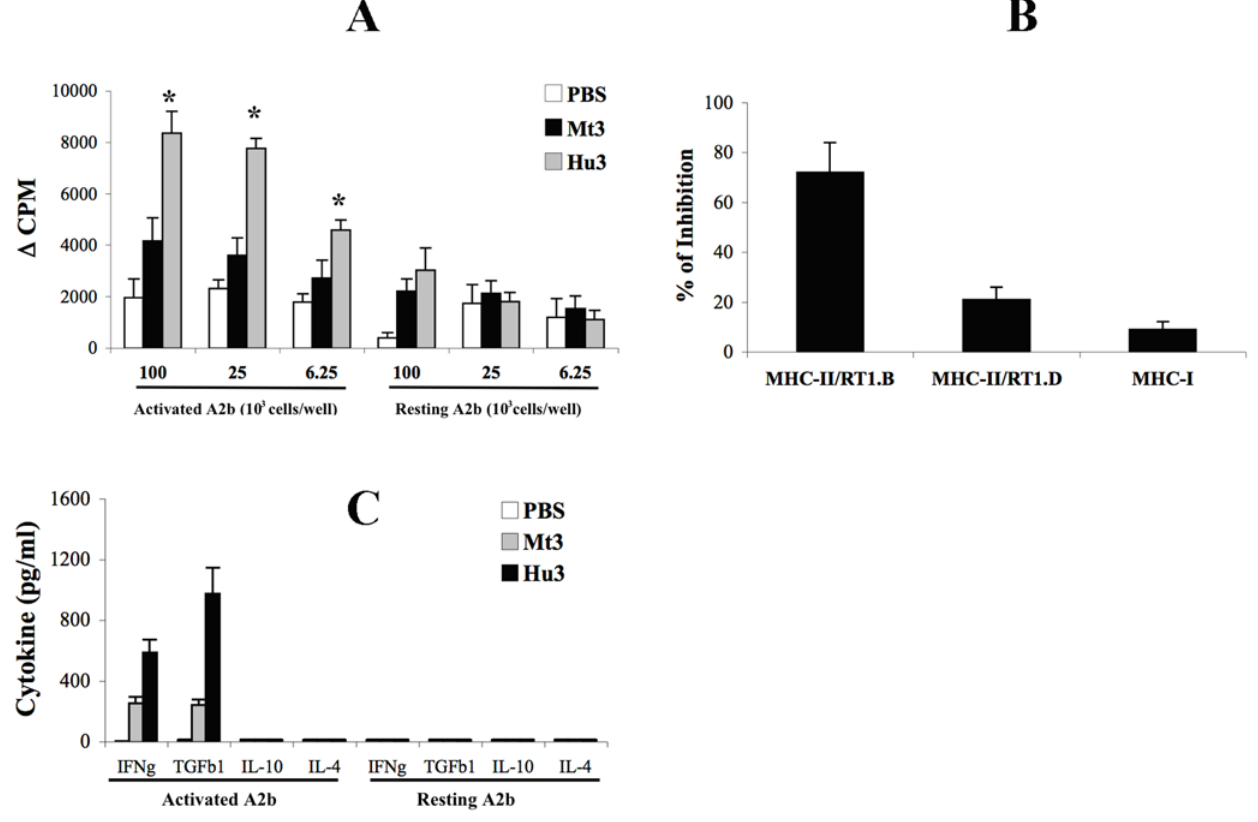
Figure 2. Vaccination with HSP60 peptide Hu3 induces anti-ergotypic T cells. A. Anti-ergotypic proliferative response of LNC from rats vaccinated with PBS, Mt3 or Hu3 in IFA, taken 26 days after AA induction. Proliferative responses are presented as the D CPM 6 SEM of quadruplicate cultures. * p , 0.05 compared to the Mt3 group. B. Monoclonal antibodies to MHC-II/RT1.B, MHC-II/RT1.D or MHC-I were assayed for their ability to block the anti-ergotypic proliferative response. Results are presented as the percent of inhibition of proliferation 6 SEM of quadruplicate cultures. C. Anti-ergotypic cytokine response of LNC taken from rats vaccinated with PBS, Mt3 or Hu3 in IFA, 26 days after AA induction. IFN c (IFNg), TGF b 1 (TGFb1), IL-10 and IL-4 were quantified in the culture supernatants after 72 hr of stimulation with 10 5 activated or resting, irradiated, A2b cells per well. The results are presented as pg/ml 6 SEM of triplicate cultures. Three independent experiments produced similar results.